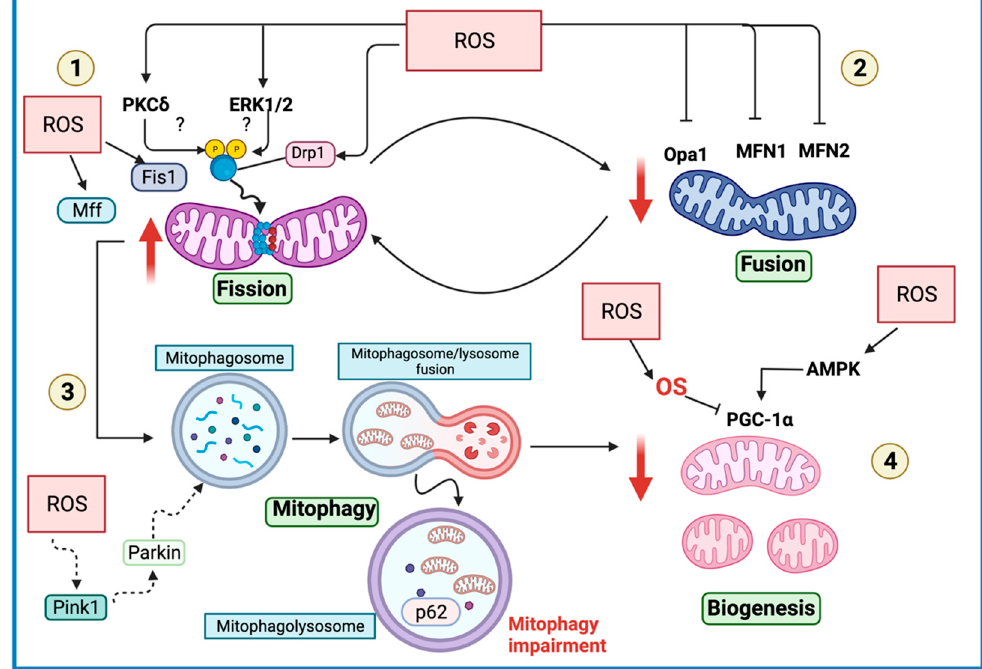
Figure 5. Redox-sensitive signaling regulates mitochondrial dynamics in kidney diseases. (1) ROS activate the redox-sensitive extracellular regulated kinase 2 (ERK2) protein and protein kinase C (PKC) isoform δ (PKC- δ ). These proteins phosphorylate and activate dynamin-related protein 1 (Drp1), inducing its translocation to the OMM to triggering fission. Likewise, ROS overproduction upregulates Drp1, fission 1 (Fis1), and mitochondrial fission factor (Mff), inducing fission increase. (2) ROS also induce fusion decrease by downregulating optical atrophy 1 (Opa1) and mitofusin 1 (Mfn1) and 2 (Mfn2) proteins. (3) The augment of fission promotes mitophagy activation by inducing the translocation of phosphatase and tensin homolog (PTEN)-induced putative kinase 1 (Pink1) that in turn recruit to parkin in the OMM to induce mitophagosome formation. Mitophagosome fuses with lysosome to form mitophagolysome formation. However, mitophagy flux is impaired, inducing the accumulation of damaged mitochondria. (4) Low ROS levels induce mitochondrial biogenesis by activating the redox-sensitive adenosine monophosphate (AMP)-activated protein kinase (AMPK) and the peroxisome proliferator-activated receptor (PPAR) γ coactivator-1 alpha (PGC-1 α ). However, high levels of ROS producing oxidative stress (OS) induce mitochondrial biogenesis decrease, triggering mitochondrial mass decrease. Created with BioRender.com .